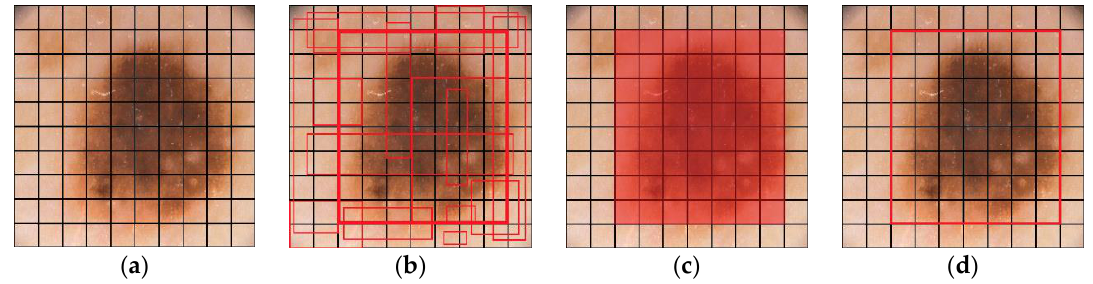
Figure 2. A sample representation (image IMD002) of skin lesion location detection by YOLO. ( a ) S × S grid input, ( b ) bounding boxes are generated with confidence score, ( c ) class probability mapping, ( d ) final lesion location detection.